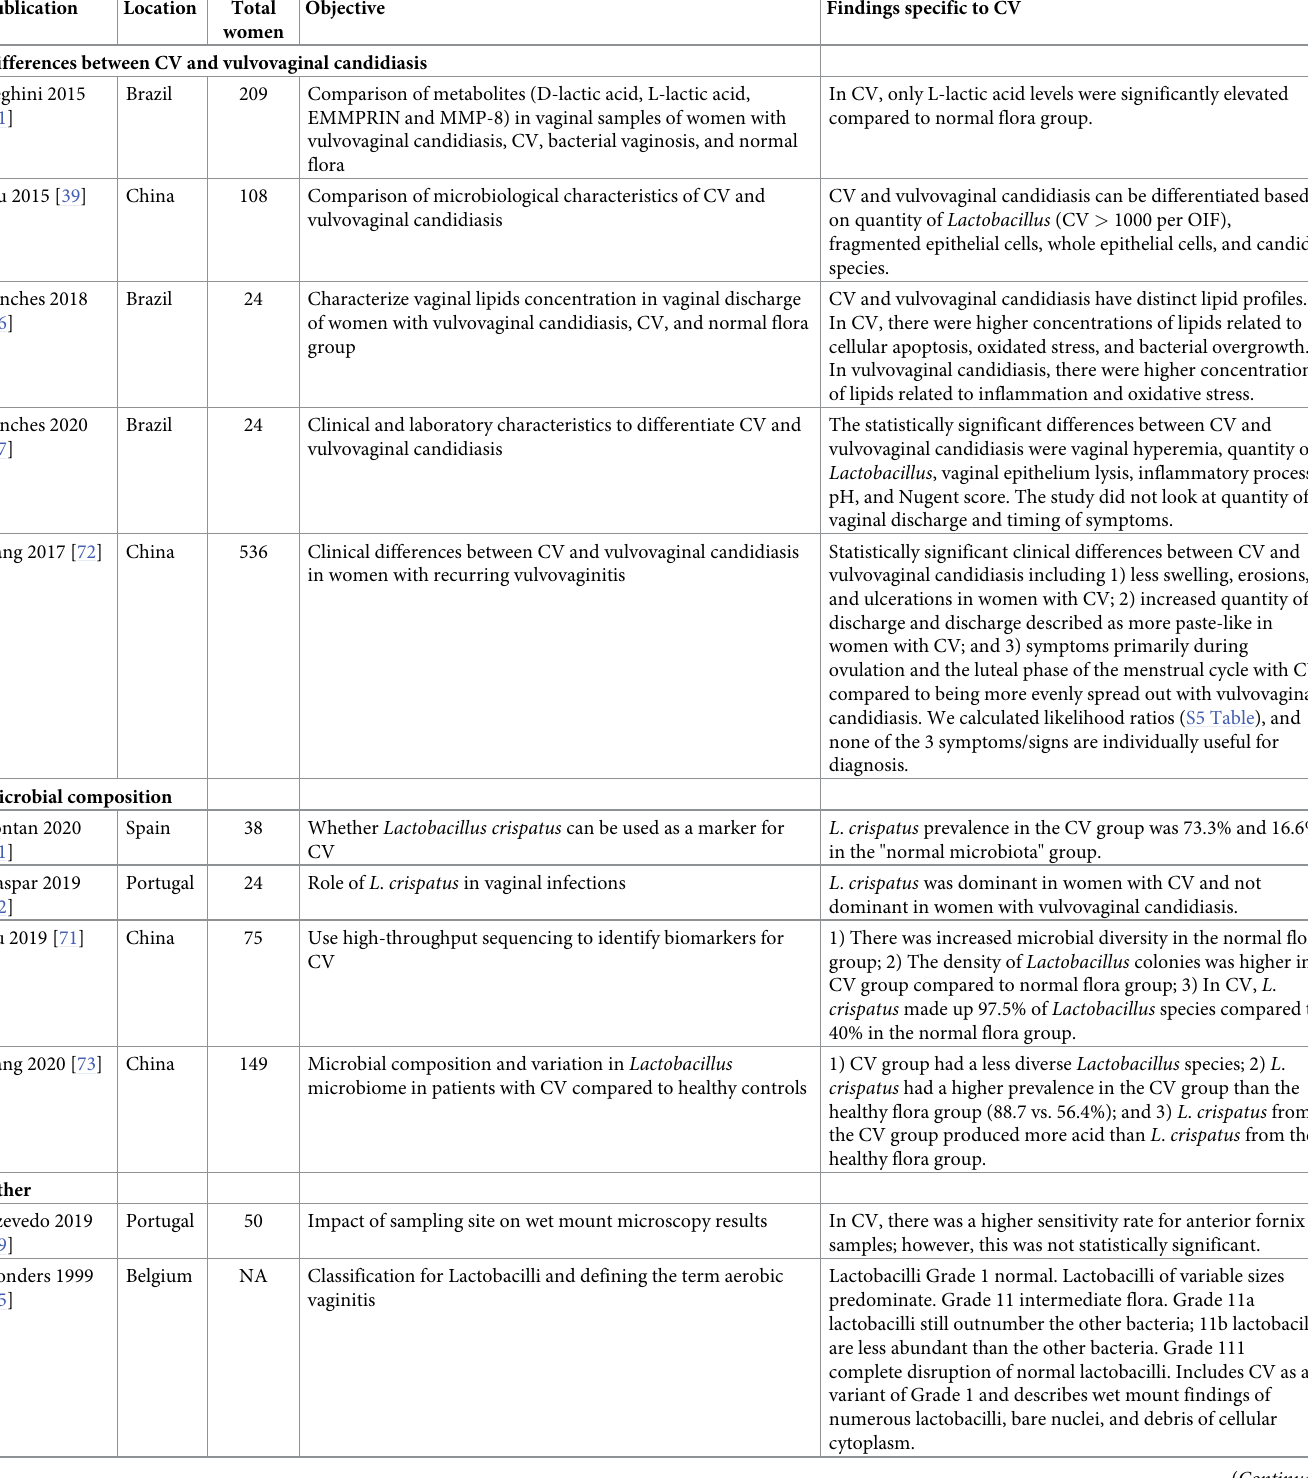
Table 4. Diagnosis studies (n = 12